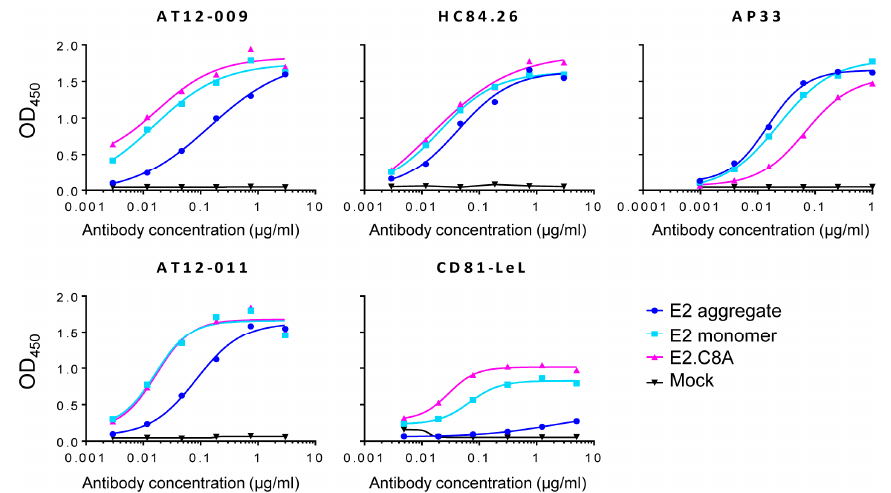
Figure 3. Antigenicity of E2 and E2.C8A. Strep-Tactin coated ELISA plates were loaded with 1.0 μ g/mL of StrepTactin/SEC-purified E2 (aggregates and monomers) or E2.C8A (monomer) proteins and were reacted against serial dilutions of different